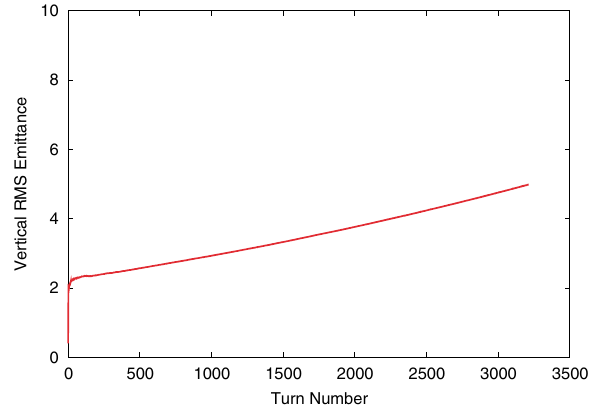
FIG. 25. (Color) Simulated vertical rms emittances during the accumulation of a high intensity beam in a PSR phase- advance-equivalent, uniform focusing